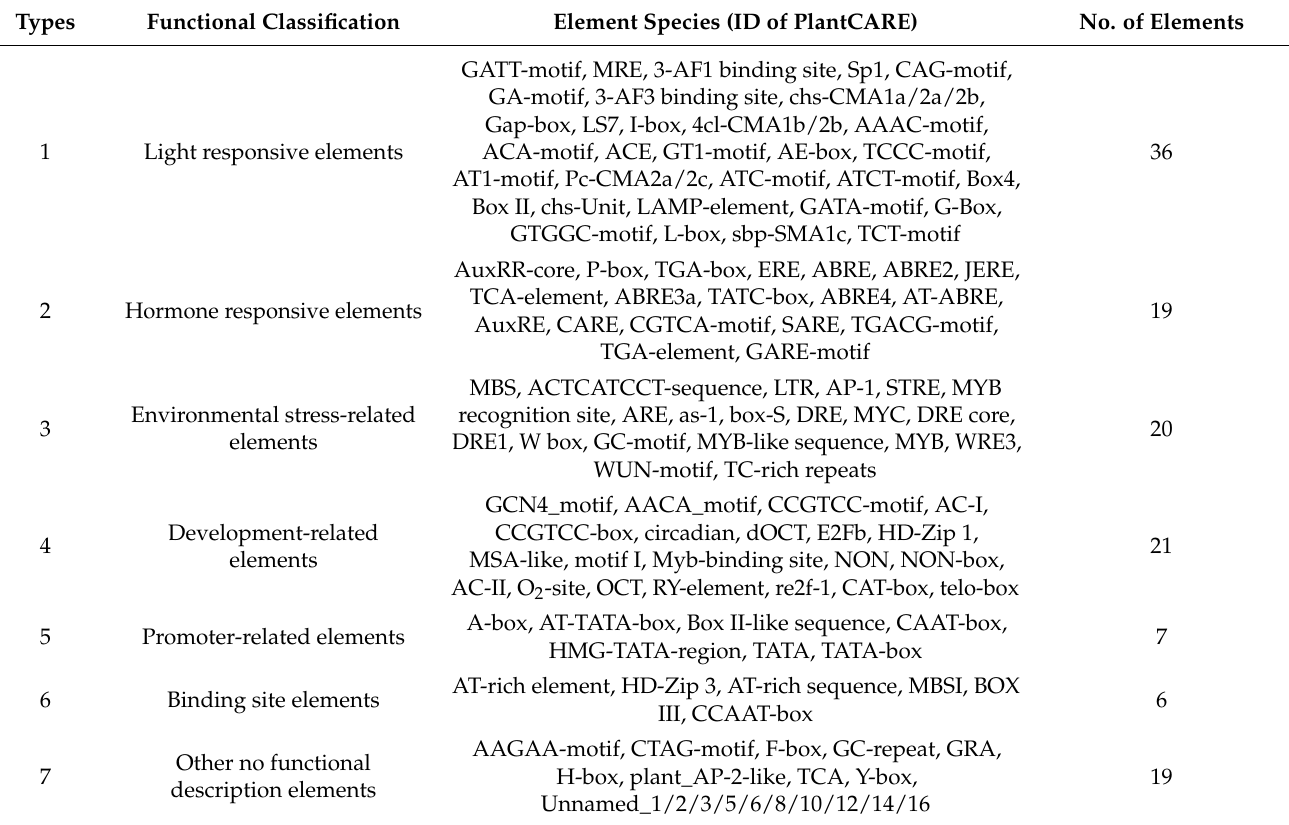
Table 2. Statistics analysis of cis -acting elements detected in promoter of SsLRR-RLK